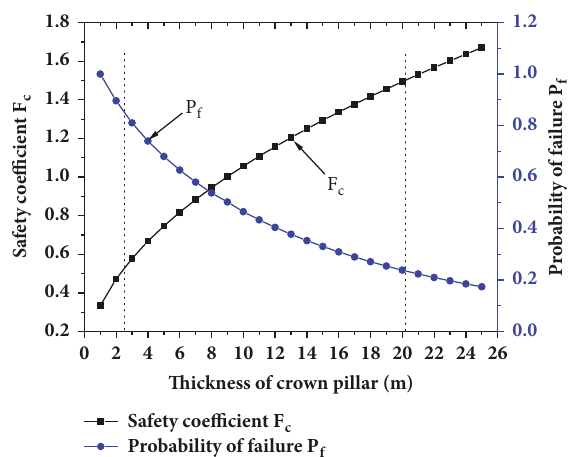
Figure5:Therelationshipsbetweenthethicknessofthecrownpillar and both the safety factor and probability of failure.